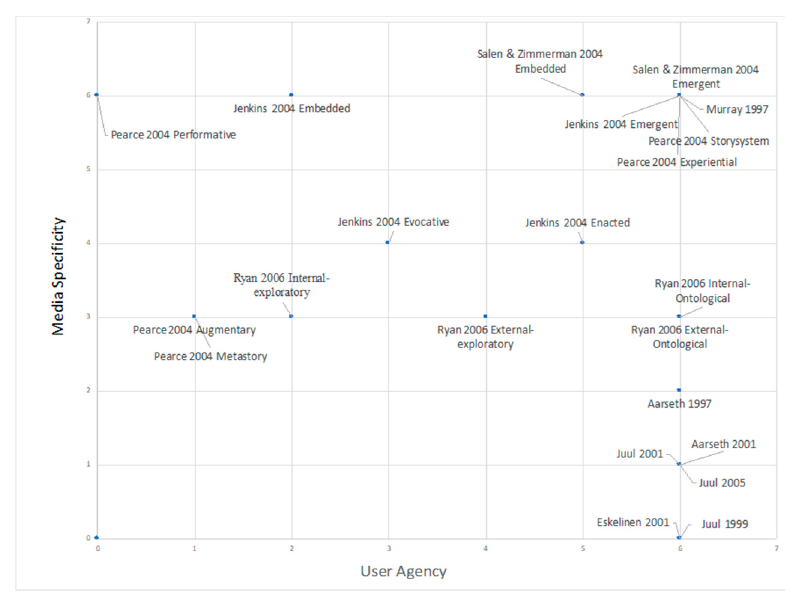
Figure 1. Spatial mapping of different ontological positions on interactive digital narrative.